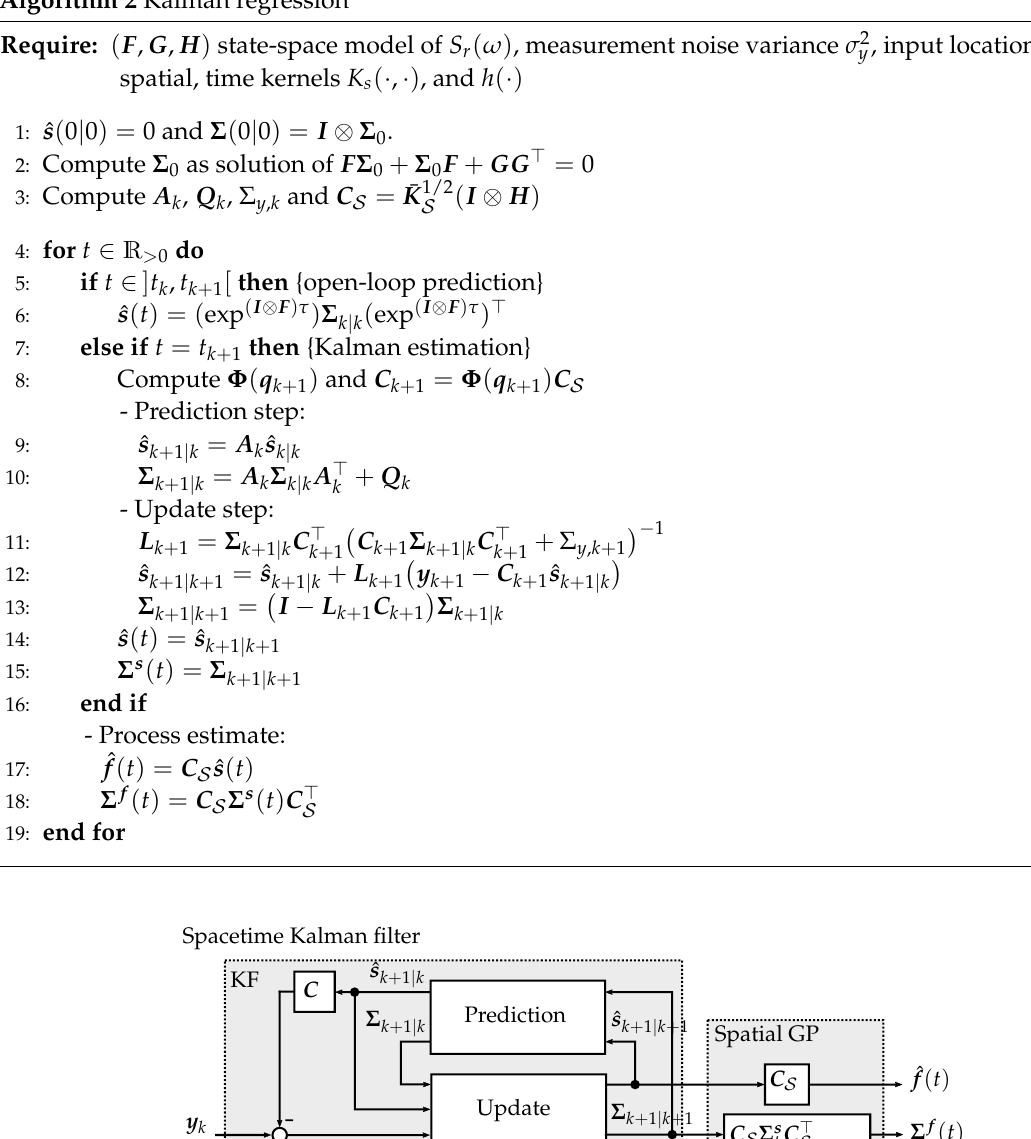
Algorithm 2 Kalman regression